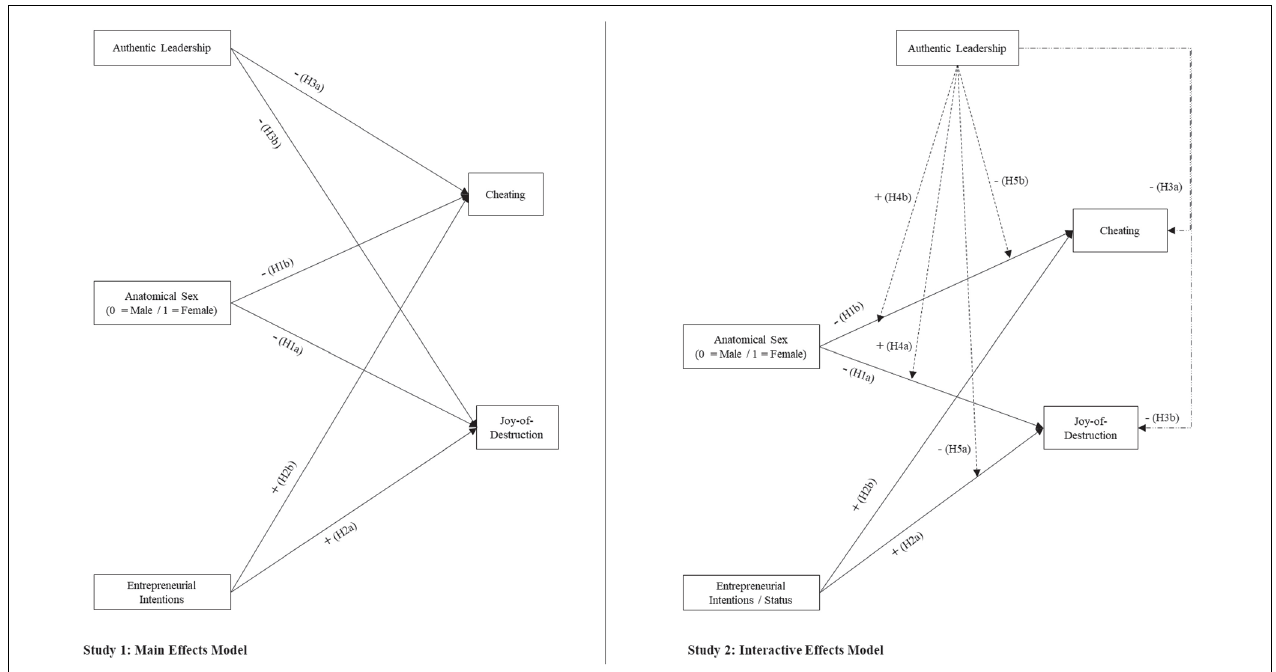
FIGURE 1 | Theoretical model describing main (left) and interactive effects